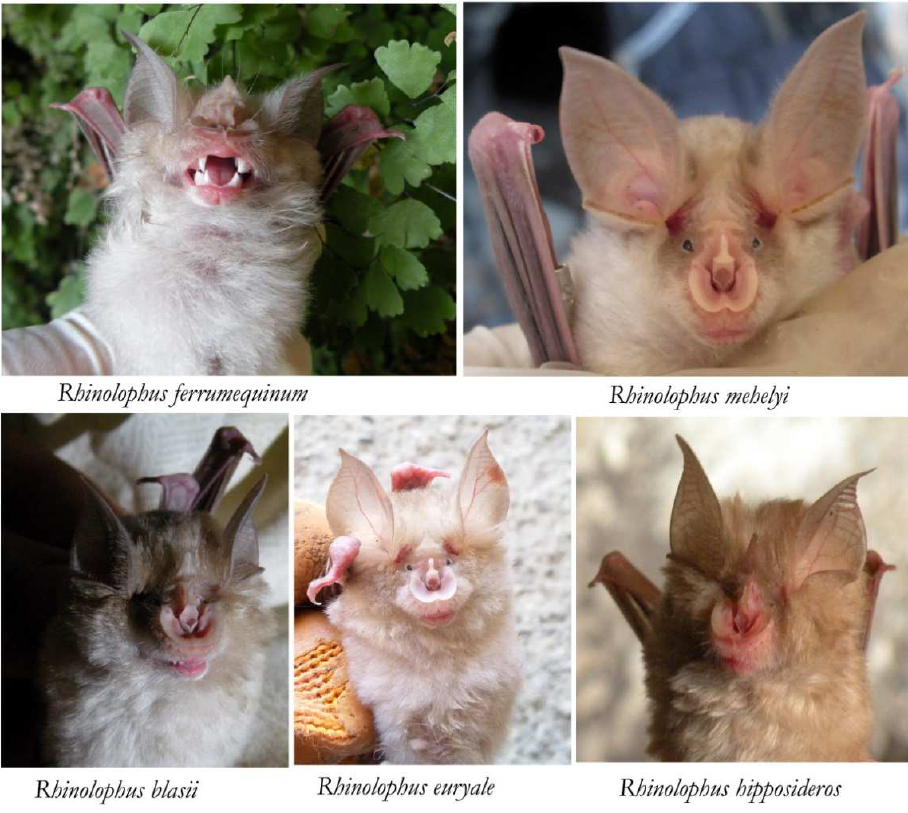
F IGURE 3. Bat species of Rhinolophidae family recorded in this